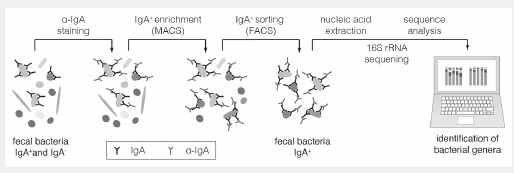
Identification of disease-associated bacterial consortia in the gut. The bacteria coated with IgA in faecal material can be labelled with an antibody directed against IgA. IgA-coated bacteria are then enriched by magnetic-activated cell sorting (MACS), purified by fluorescence-activated cell sorting (FACS) and sequenced by 16S ribosomal RNA sequencing to identify the IgA coated